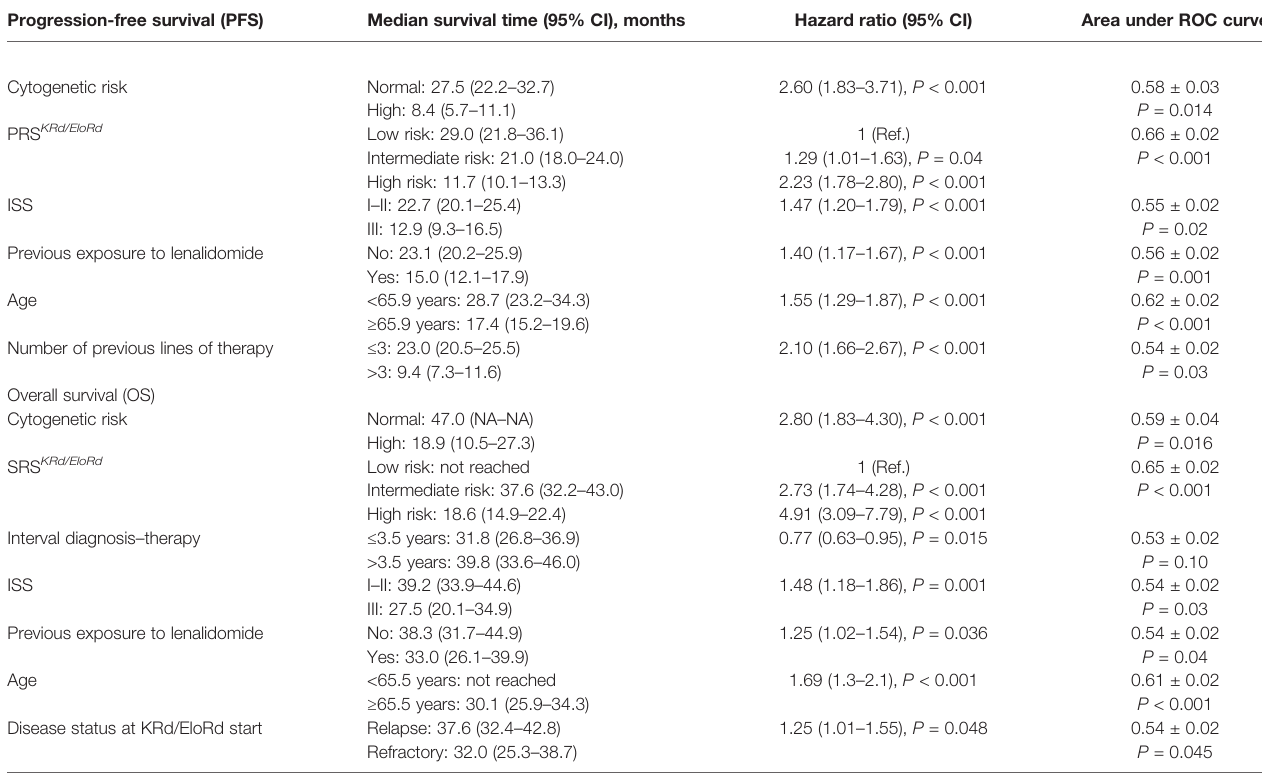
TABLE 2 | Median survival time (and 95% CI), hazard ratio (and 95% CI), and area under the ROC curve of the proposed risk prediction rules, the components from which they were built and the markers that were excluded. Progression-free survival (PFS) Median survival time (95% CI),